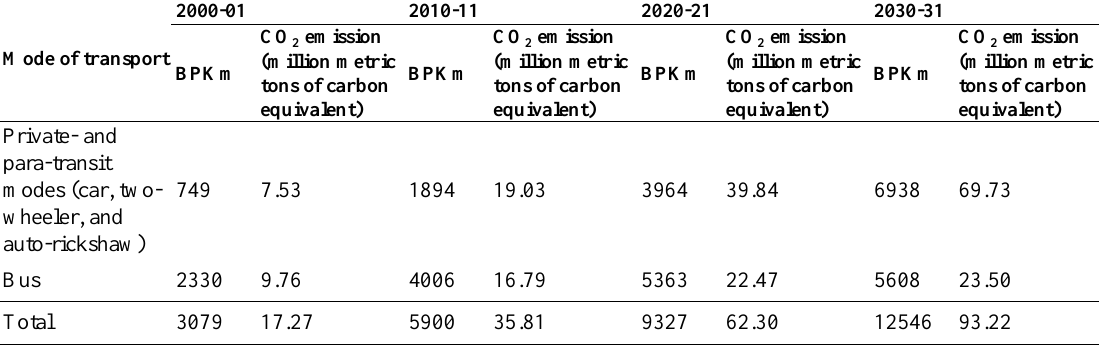
Table 9. The level of CO emission from road passenger transport in India; business as 2 usual